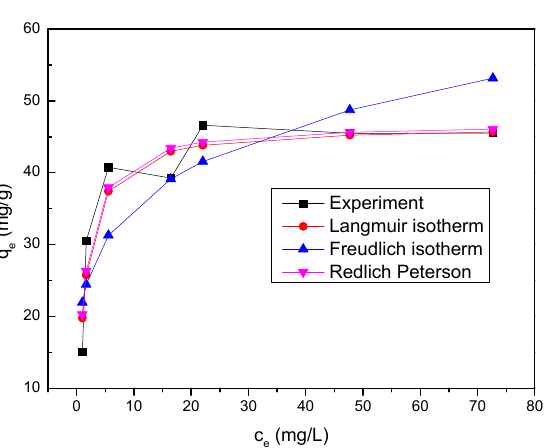
Figure 10. Adsorption isotherm for Se(IV) onto nZVI/rGO composites (nZVI/rGO dosage = 30 mg; initial pH = 8.0; t = 1 h; T = 25 °C).